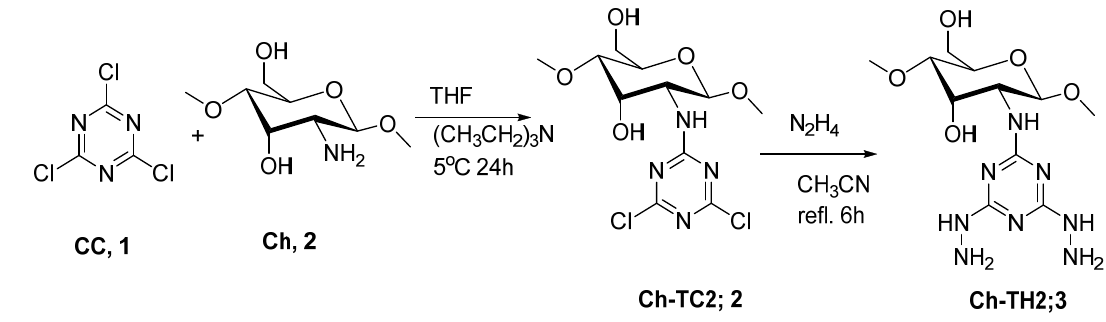
Figure 1. 1 HNMR spectrum of ( a ) chitosan modified with triazine dihydrazide moiety (HCh-TH2) and ( b ) high chitosan (HCh).